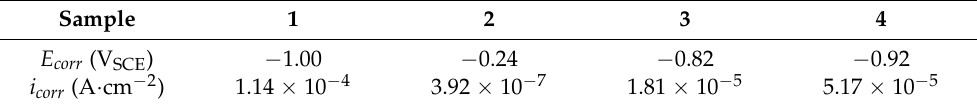
Table 3. Electrochemical parameters extracted from potentiodynamic polarization curves (Figure 6).